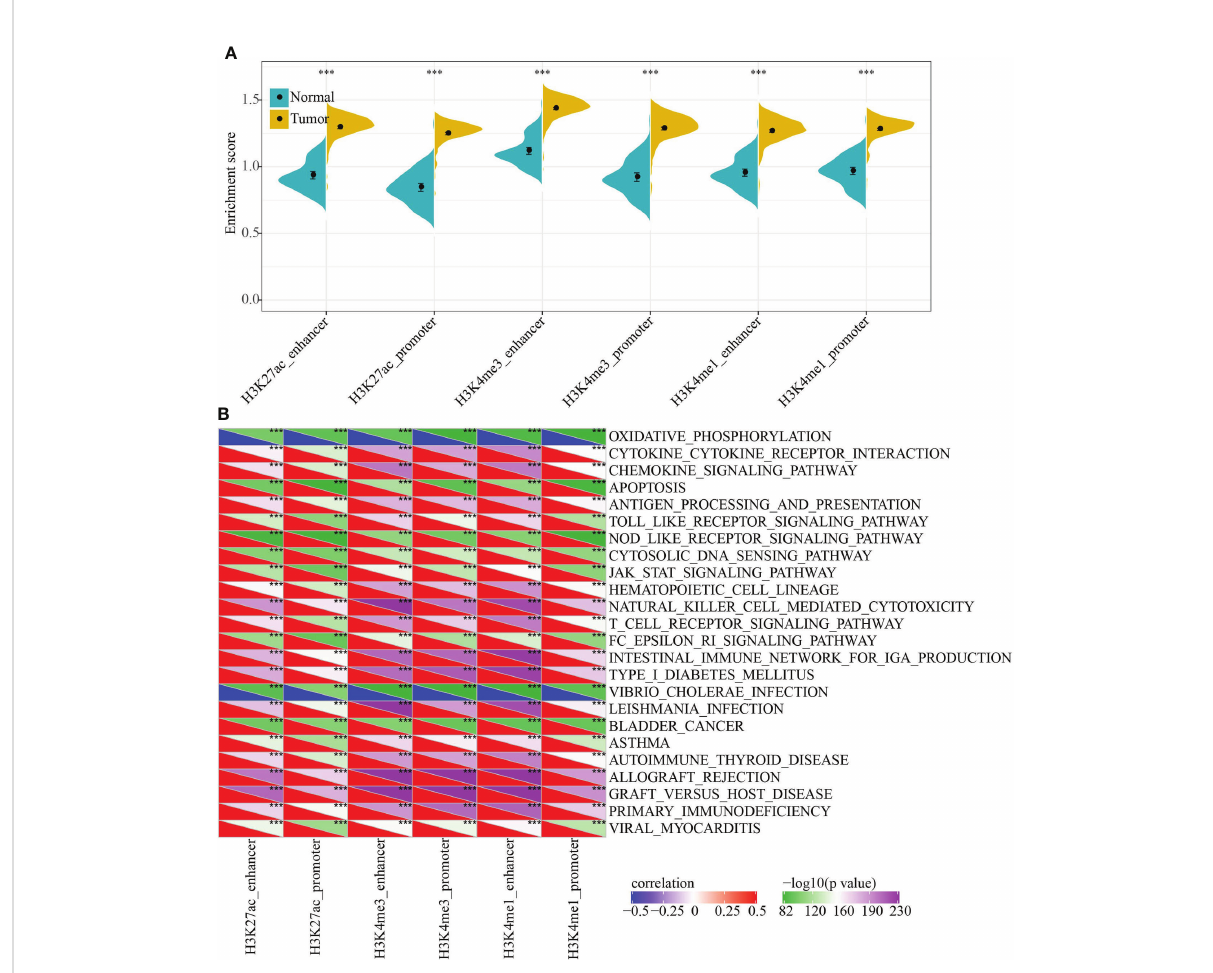
FIGURE 3 Functional enrichment analysis of epi-PCGs. (A) Differential expression of 6 kinds of epigenetically dysregulated PCGs in cancer (n = 319) and adjacent cancer (n = 160) tissues; (B) The most relevant KEGG Pathway enriched by the 6 kinds of dysregulated PCGs. ***P <